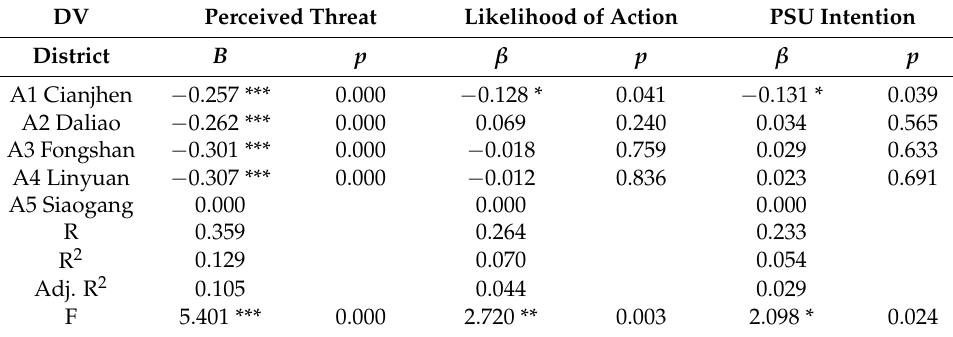
Table 5. Regressions of major constructs on